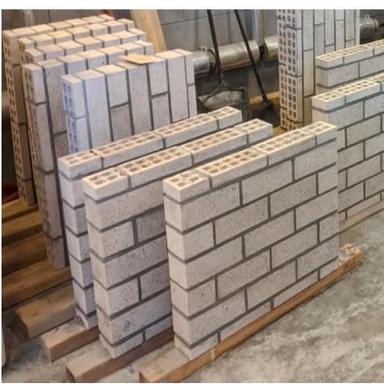
Storage of test specimen and transport setup.